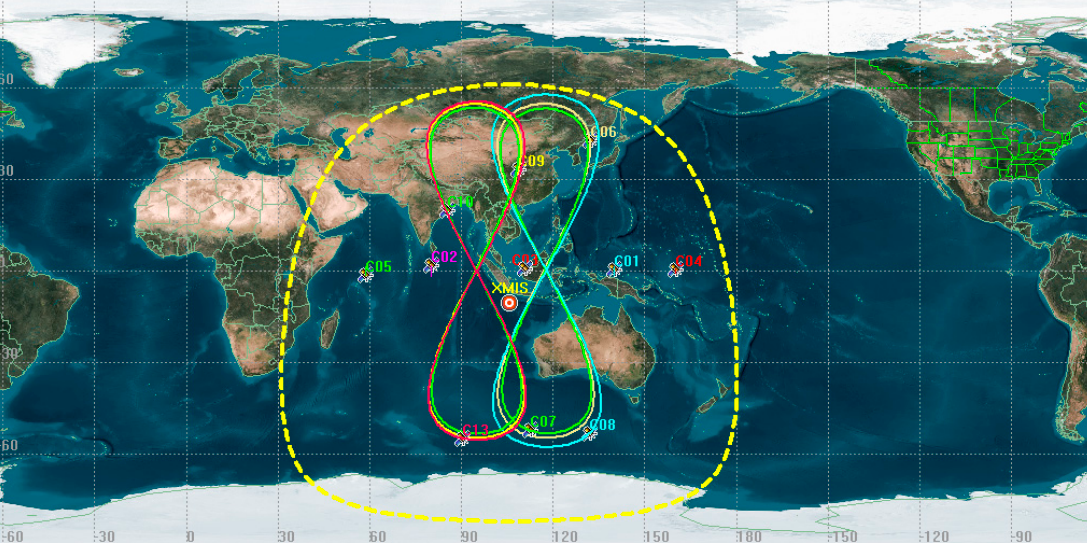
Figure 2. The data location and the distributions of the trajectories on the ground.